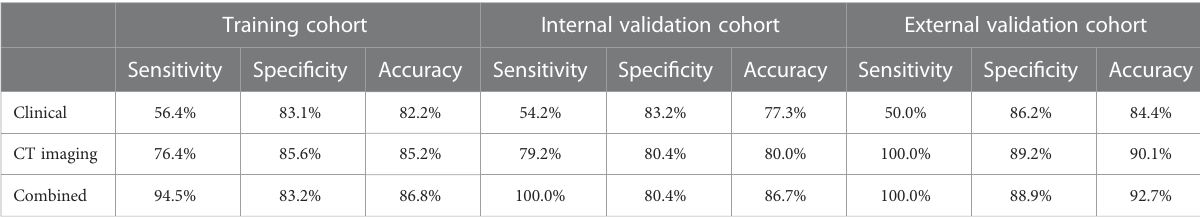
TABLE 6 Performance of three models for PM-SCLC.